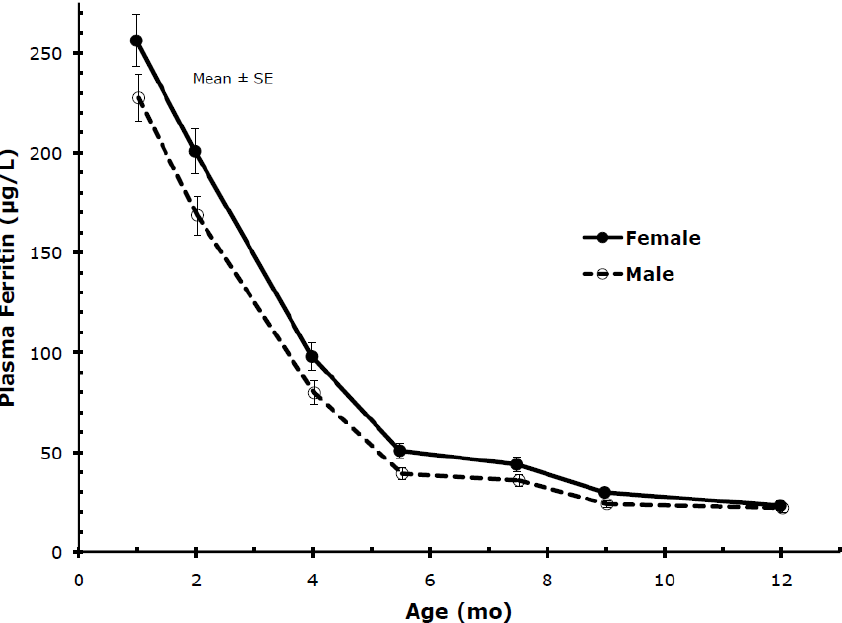
Figure 4. PF of males and females. Differences were statistically significant except at 1 and at 12 months.